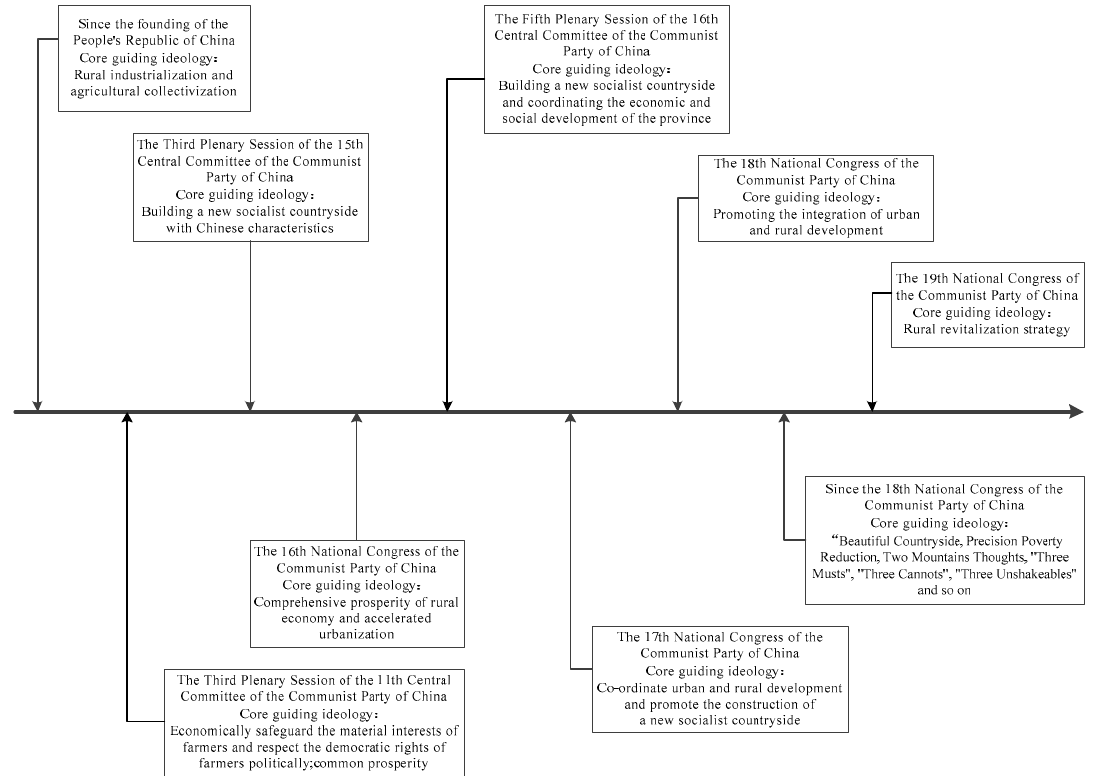
Figure 1. The historical evolution of the rural thought of Communist Party of China in the 70 years of the founding of the People’s Republic of China. Source: Authors, based on the literature.